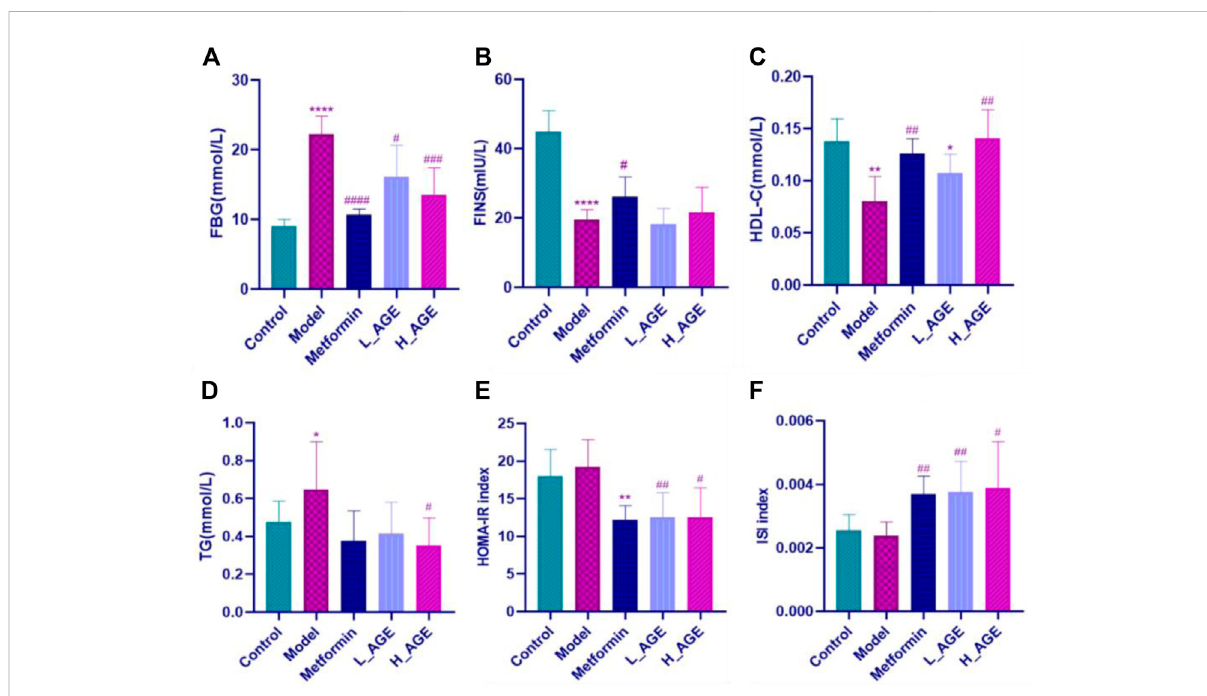
FIGURE 2 Serum biochemical marker levels in each group. (A – F) respectively represent the levels of fasting blood glucose (FBG), fasting blood insulin (FINS), high-density lipoprotein cholesterol(HDL-C), bloodtriglycerideconcentration(TG), insulinresistanceindex(HOMA-IR) andinsulinsensitivity